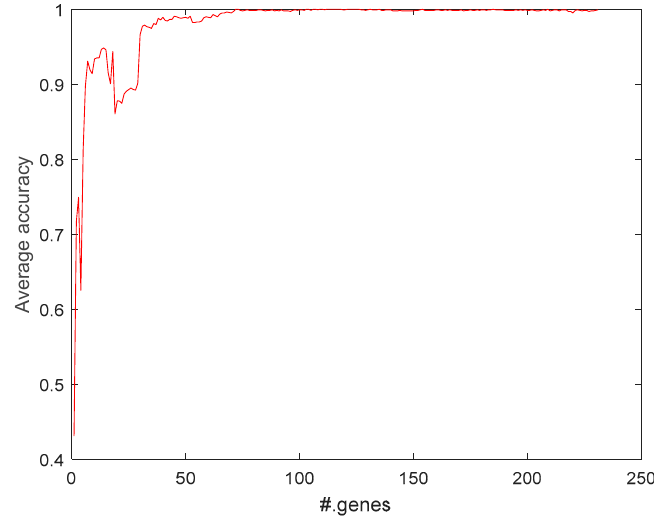
Figure 3. Average accuracy of 100 trials of v-elm trained on selected genes.